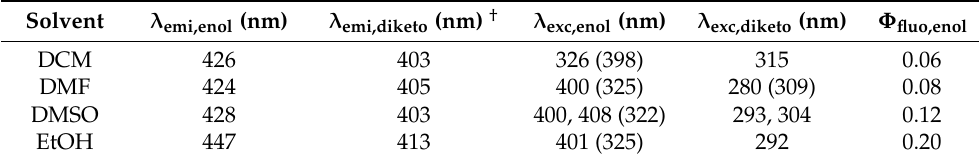
Table 3. Fluorescence properties of 1 in selected solvents: peak fluorescence emission wavelengths upon excitation at the enol, λ emi,enol , and diketo, λ emi,diketo , absorption peak; peak fluorescence excita- tion wavelengths with fluorescence recording at the enol emission peak, λ exc,enol , and at 350 nm, λ exc,diketo ; fluorescence quantum yield of the enol tautomers, Φ fluo,enol .